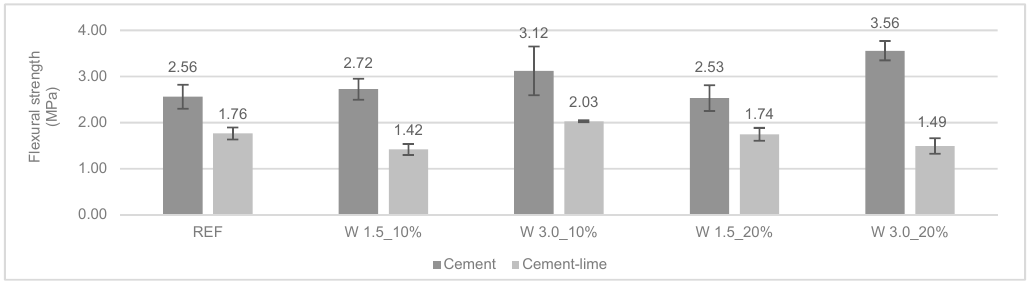
Figure 8. Ultra-sound pulse velocity of the W 1.5_10% mortar.